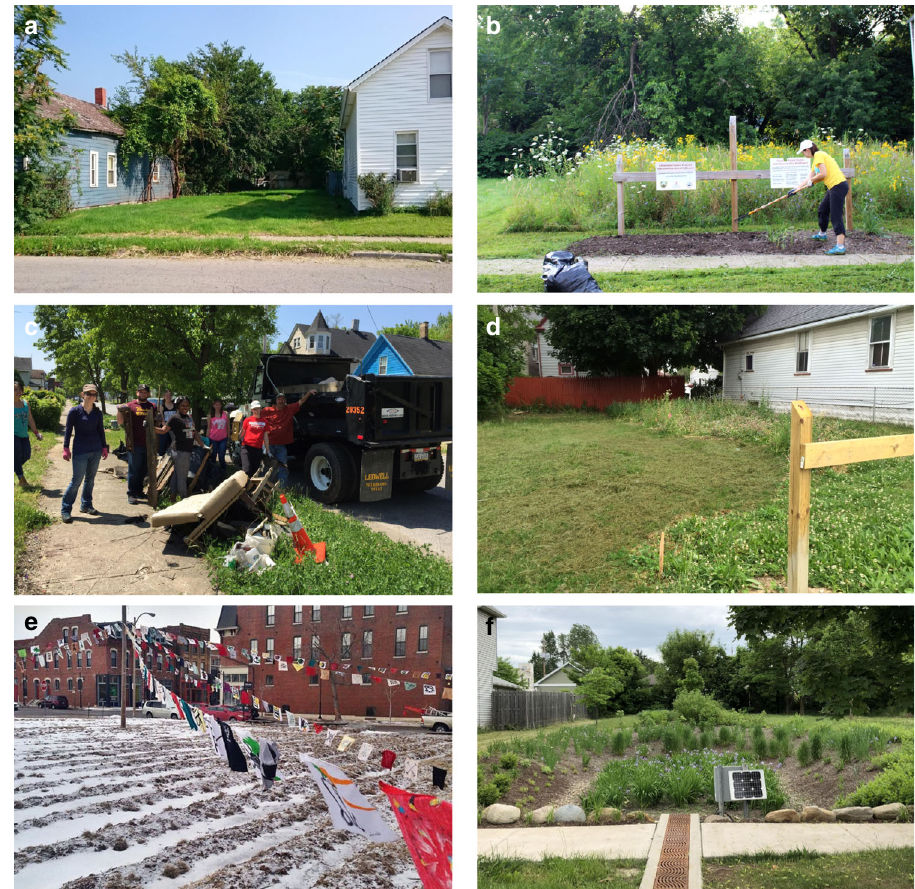
Fig. 1 Urban greening projects should anticipate challenges and plan to work collaboratively with stakeholders to address them. Post-industrial cities such as Cleveland, Ohio, USA face the signi fi cant challenge of managing thousands of vacant lots (i.e. parcels where pre-existing structures have been torn down and replaced by minimally-managed vegetation) ( a ). Although typically viewed as blight, these sites do offer opportunities to conserve urban biodiversity. In 2014, the Gardiner Laboratory established 64 conservation habits on vacant land across the city of Cleveland, including 32 sites seeded with native perennial wild fl owers ( b ). Our cost to establish the 32 pocket prairies was approximately $2500 per site and included soil preparation, seeding, invasive plant management, and installing ‘ cues to care ’ 11 such as fencing and mulching. Maintaining cues to care required substantial time and fi nancial investment. Trash, furniture, appliances, and other refuse are frequently dumped into urban lots and must be removed ( c ). Vandalism to signs, fencing,